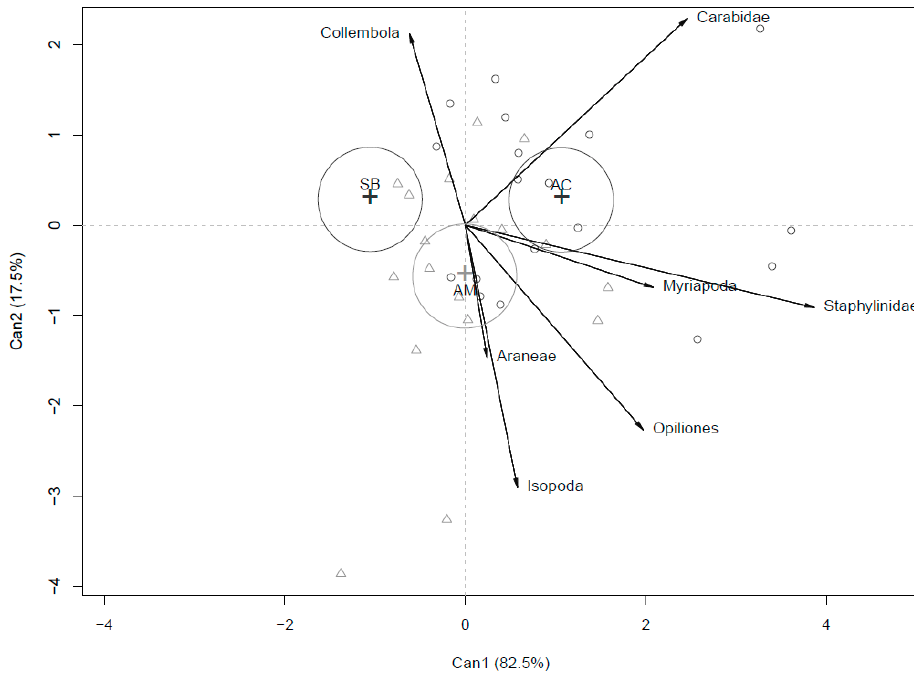
Figure 3. CDA output for arthropods abundance in the three compared systems (SB, AC and AM) pooling the two-year rotation.